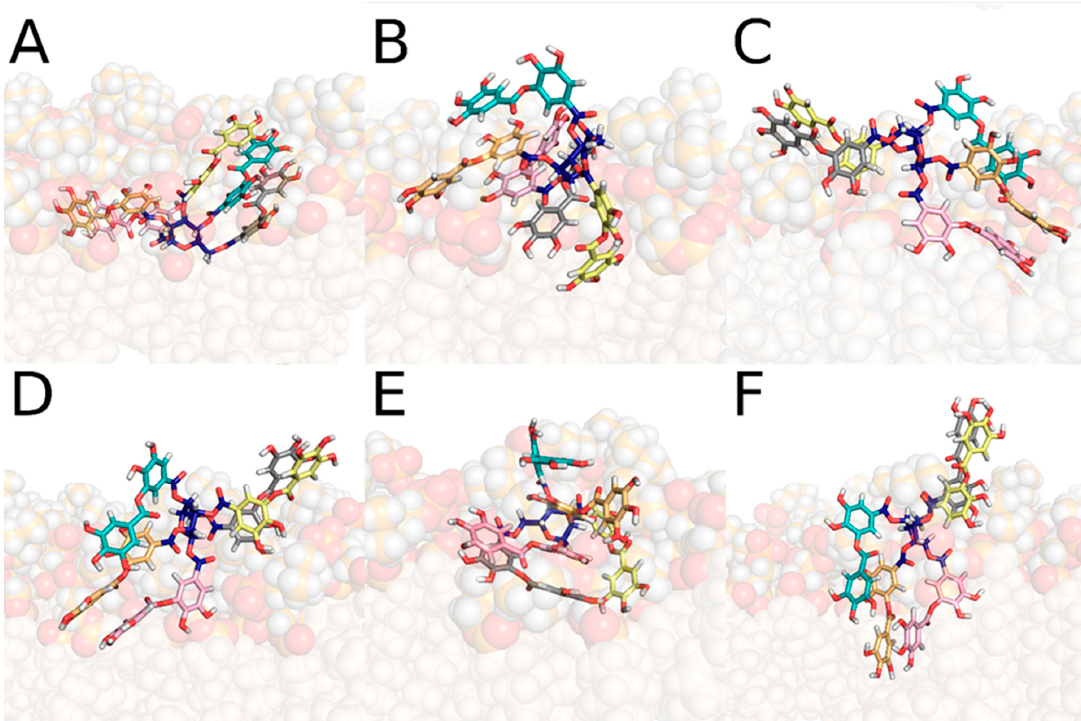
Figure 12. The six different representative structures of tannic acid in the membrane, according to the clustering analysis. The PGG is in blue, the five different gallic acid tails are in different colours. Oxygen atoms are in red, and hydrogen atoms in white. The membrane is depicted as spheres with the phosphatidylcholine headgroups in dark orange with hydrogens and oxygens; the tail carbon atoms are pale orange spheres.